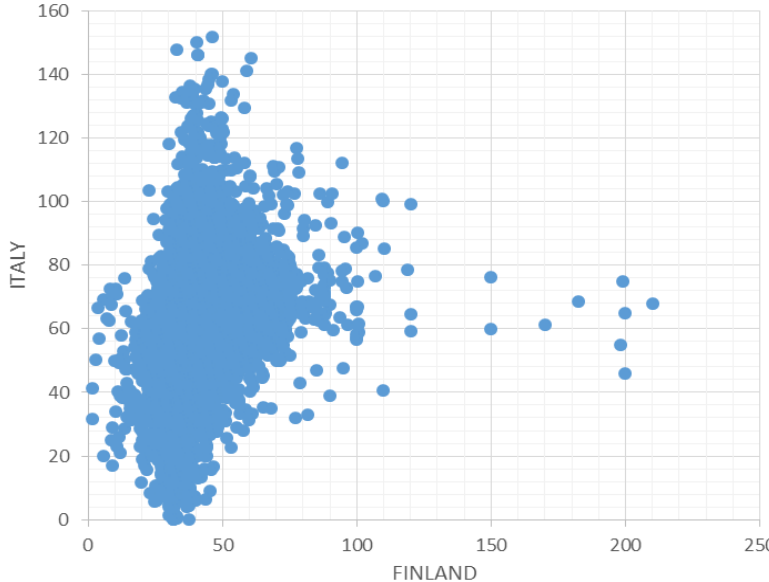
Figure 28. Scatter plot of the market prices in Finland and Italy.